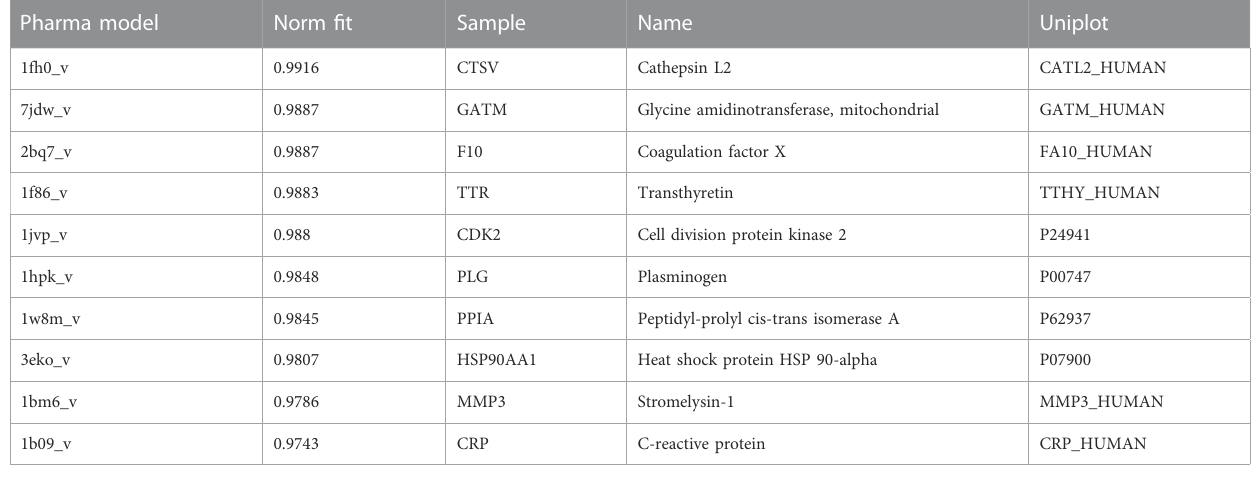
TABLE 1 Top ten pharmacophore candidates identi fi ed by PharmMapper.